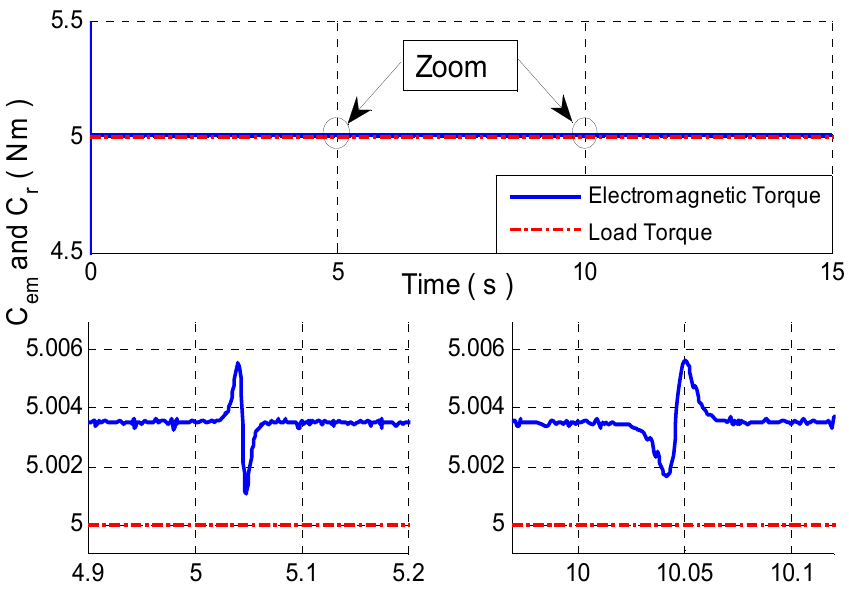
Figure 7. Electromagnetic torque with zoom.